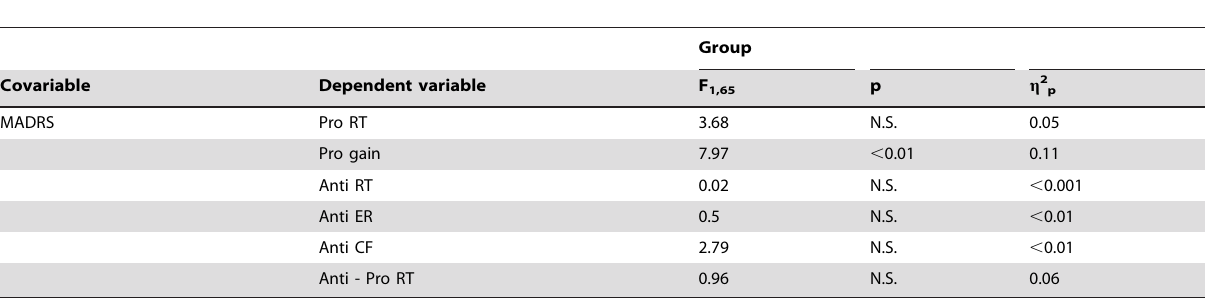
Table 3. Eye movement performances 6 MADRS interaction between the 2